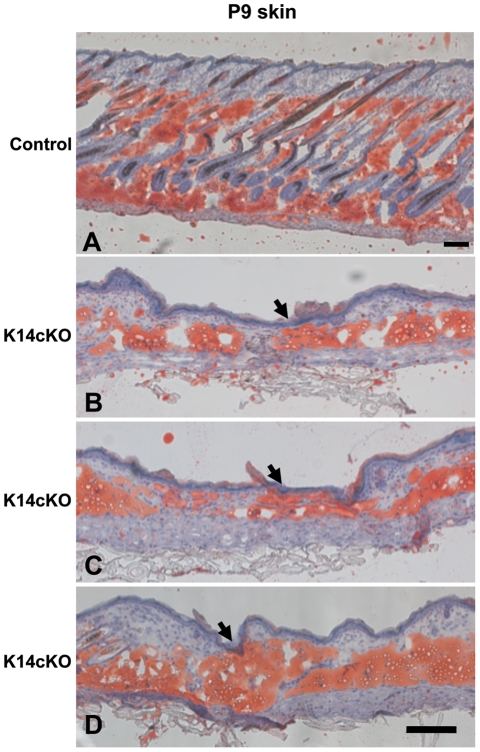
Oil red O staining of Krt14cKO skin at P9.(A) Control skin. Scale bar 100 µm. (B–D) Krt14cKO skin shows fat apposition close to the surface. Scale bars 50 µm.